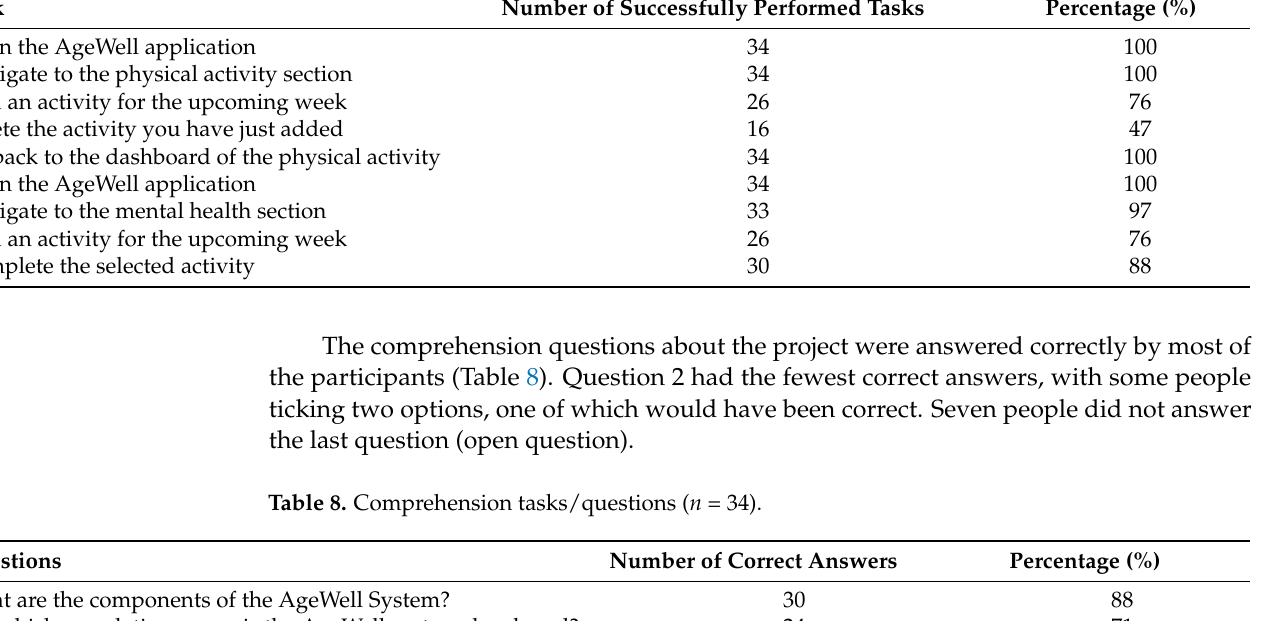
Table 7. Tasks to be completed ( n = 34).